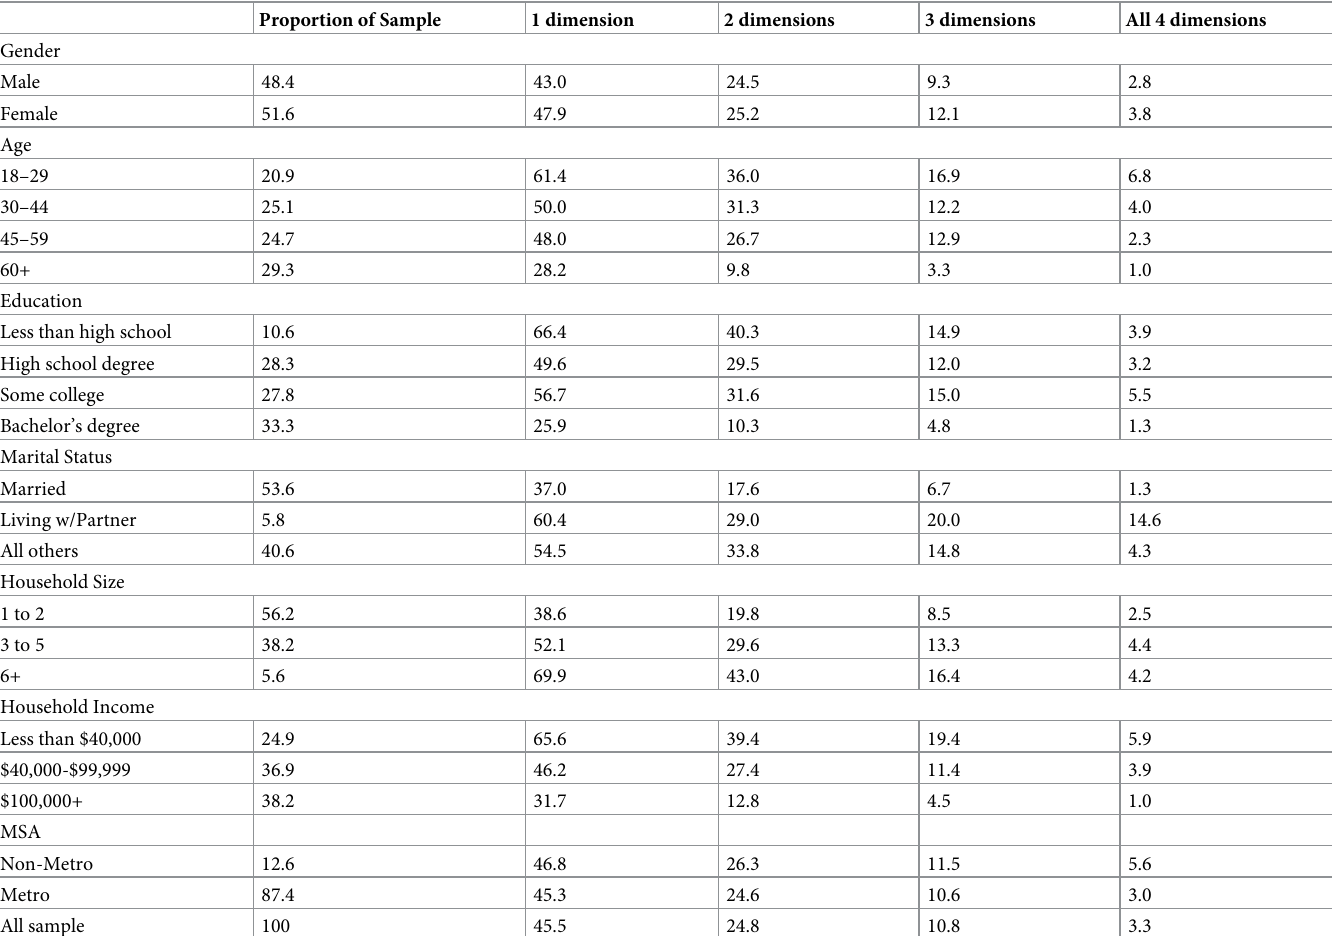
Table 6. Multidimensional deprivation by other demographic